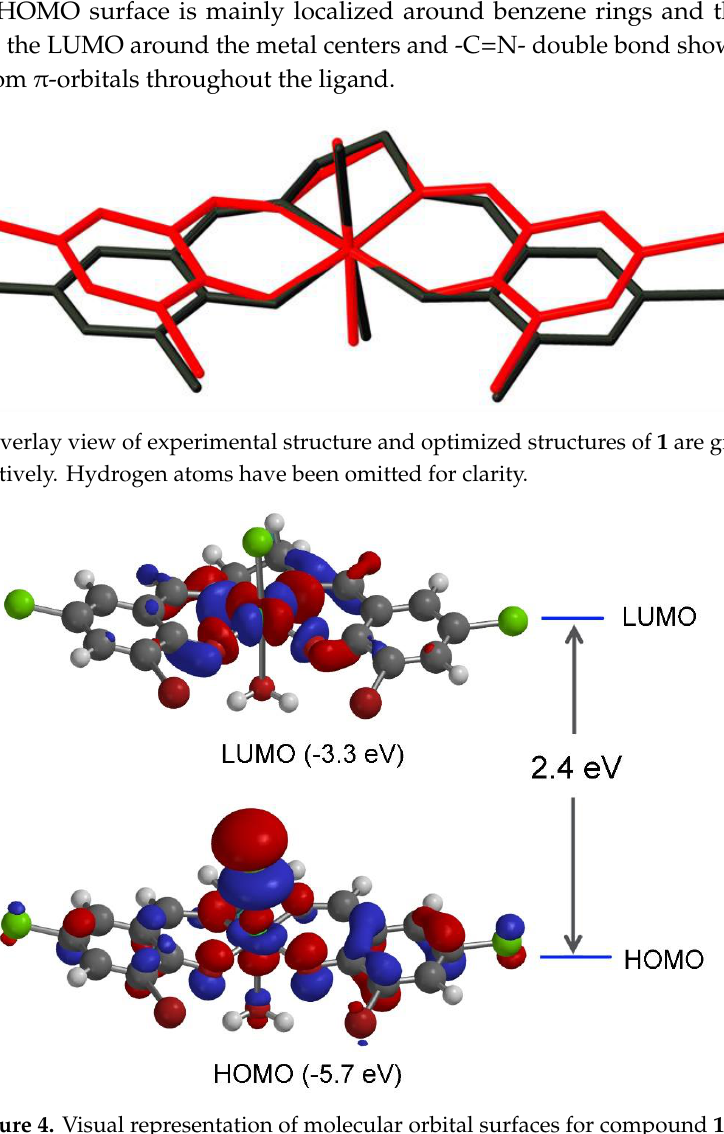
Figure 4. Visual representation of molecular orbital surfaces for compound